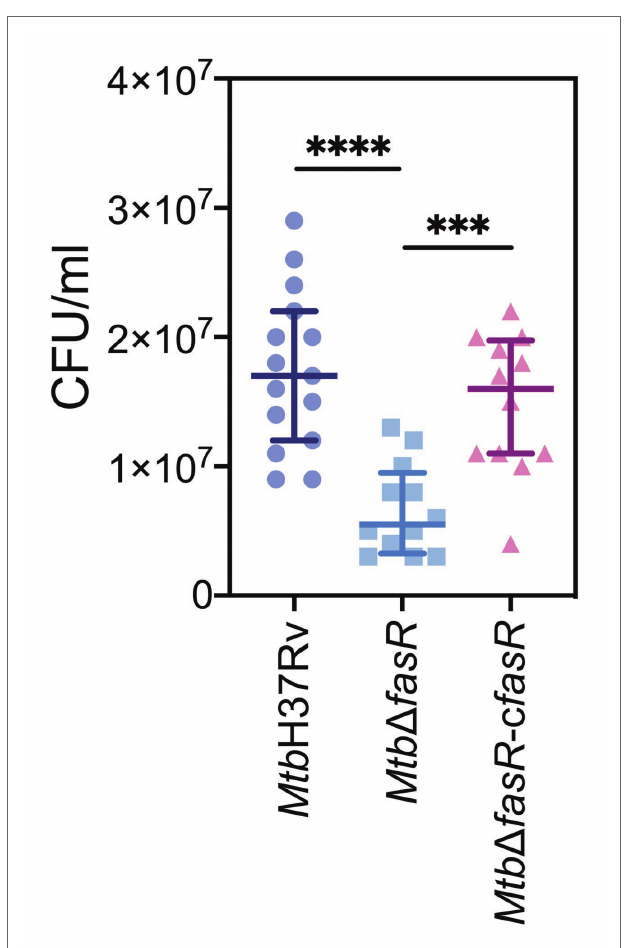
FIGURE 6 | FasR is essential for the multiplication of mycobacteria in mouse lungs. Three groups of BALB/c mice (10 per group) were infected intratracheally with 10 2 CFU of wild type M. tuberculosis H37Rv ( Mtb H37Rv), fasR mutant ( Mtb Δ fasR ) and the complemented fasR strain ( Mtb Δ fasR - cfasR ). Bacterial loads in lungs were determined 60 days post-infection. Data represent medians with interquartile range. Data were analyzed using Brown- Forsythe and Welch ANOVA tests with Dunnett’s T3 multiple comparisons test ( *** p ≤ 0.001; **** p ≤